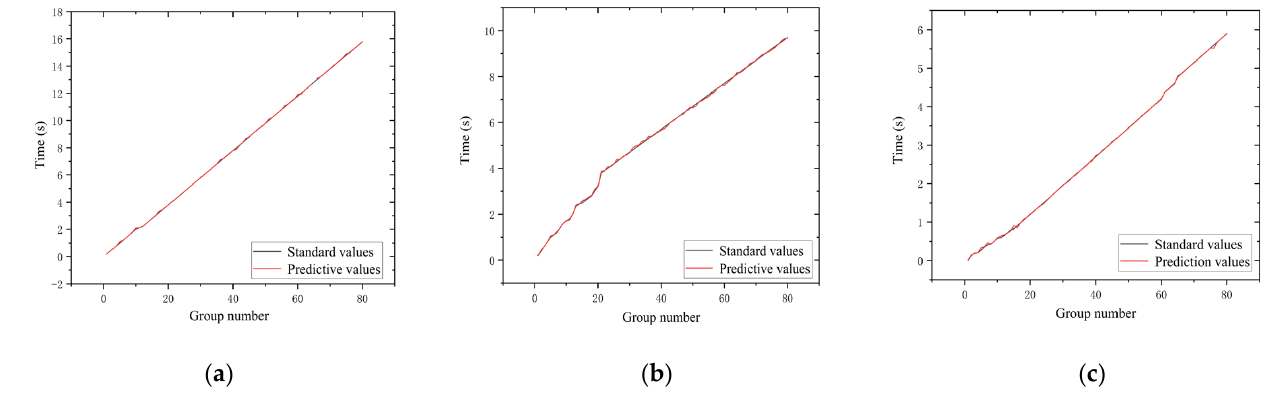
Figure 19. Time − standard value vs. predicted value. ( a ) 20 mm/s. ( b ) 40 mm/s. ( c ) 60 mm/s.